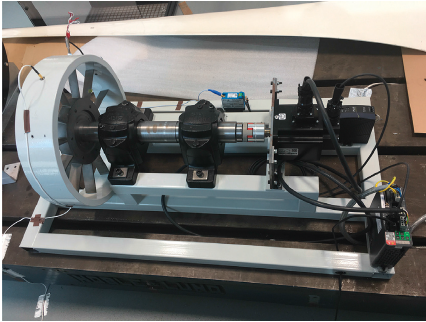
Figure 6: The manufactured test